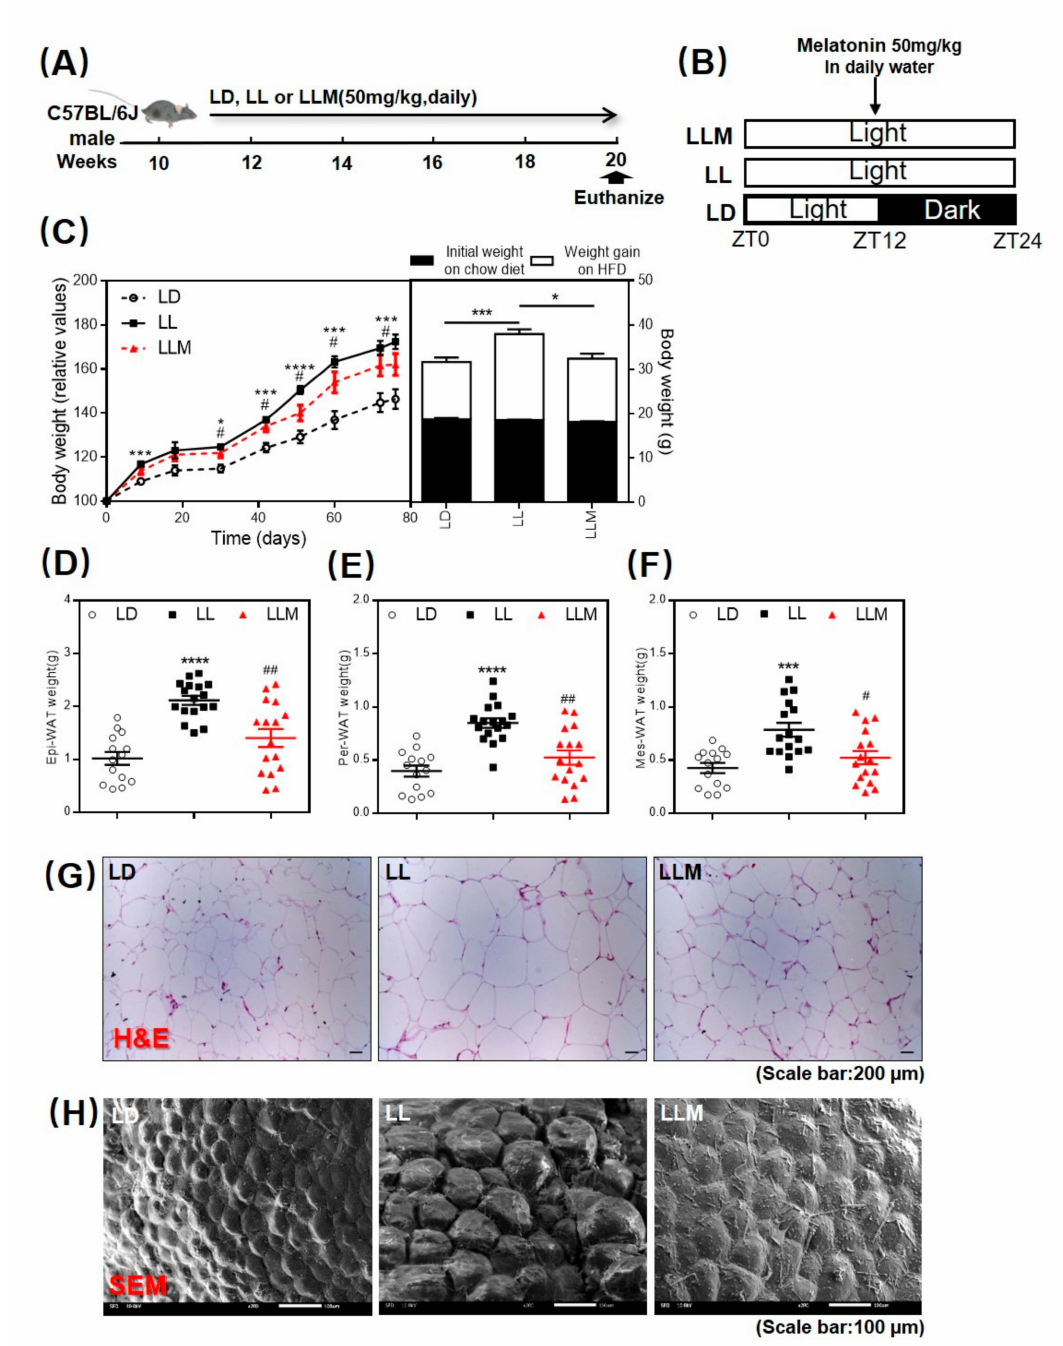
Figure 1. Melatonin shows an antiobesity e ff ect in high-fat diet (HFD) fed mice with constant light. ( A ) Conceptual graph of the treatment group in mice. ( B ) Experimental design of the three groups. ( C ) Relative body weight value and body weight. ( D ) Epididymal white adipose tissue (Epi-WAT) weight, ( E ) Perirenal white adipose tissue (Per-WAT) weight, and ( F ) Mesenteric white adipose tissue (Mes-WAT) weight in the LD (12 h light-12 h dark cycle), LL (24 h light), and LLM (24 h light and treated with melatonin) groups. ( G ) Hematoxylin and eosin (H&E) staining of Epi-WAT sections (scale: 100 µ m). ( H ) SEM of Epi-WAT sections (scale: 100 µ m). Values are presented as the mean ± SEM. N = 16–20, * p < 0.05; ** p < 0.01; *** p < 0.001 compared with LD, # p < 0.05; ## p < 0.01; ### p < 0.001 compared with LL by one-way